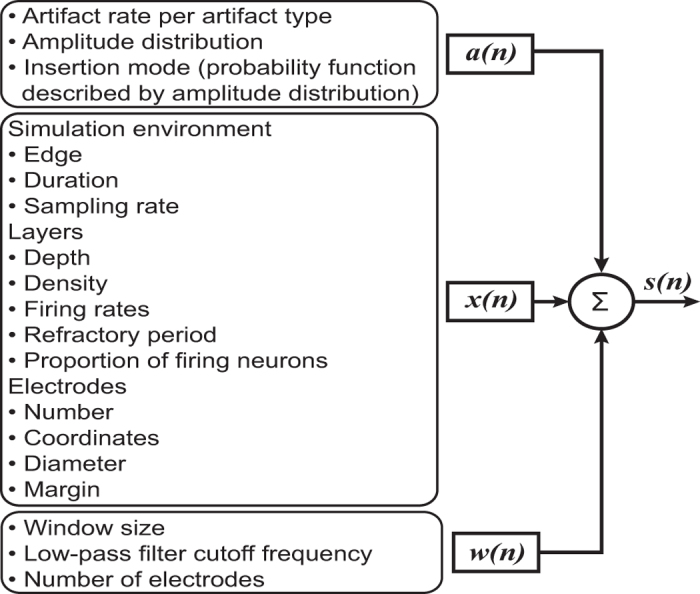
Configuration parameters of the benchmark dataset generator.For each computing module in the benchmark dataset generator, the user has rapid access to allow its modification through a unique file descriptor (.xml file) to easily create different datasets. The parameters are listed inside the text boxes next to each computing module.